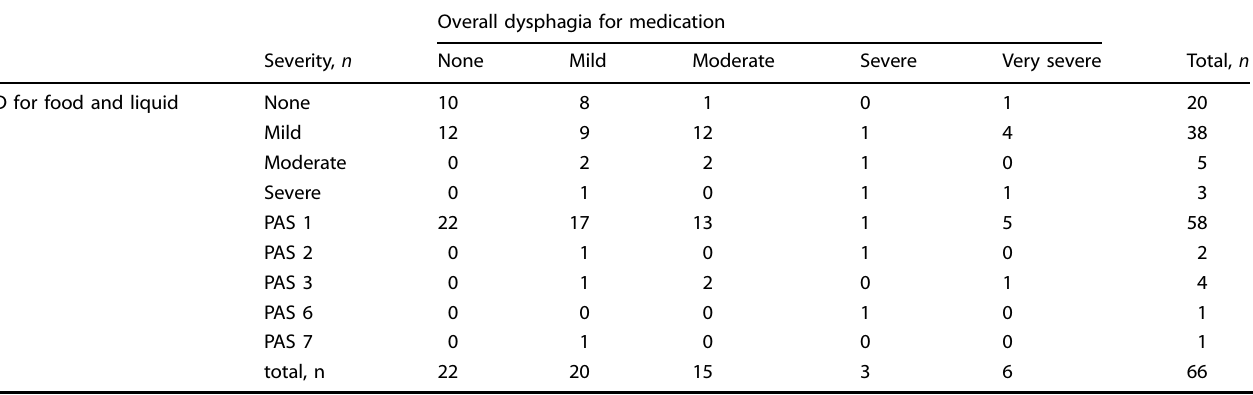
Table 3. Cross-tabulation of the severity of oropharyngeal dysphagia for food and liquid and overall dysphagia for medication: OD oropharyngeal dysphagia, PAS Penetration Aspiration